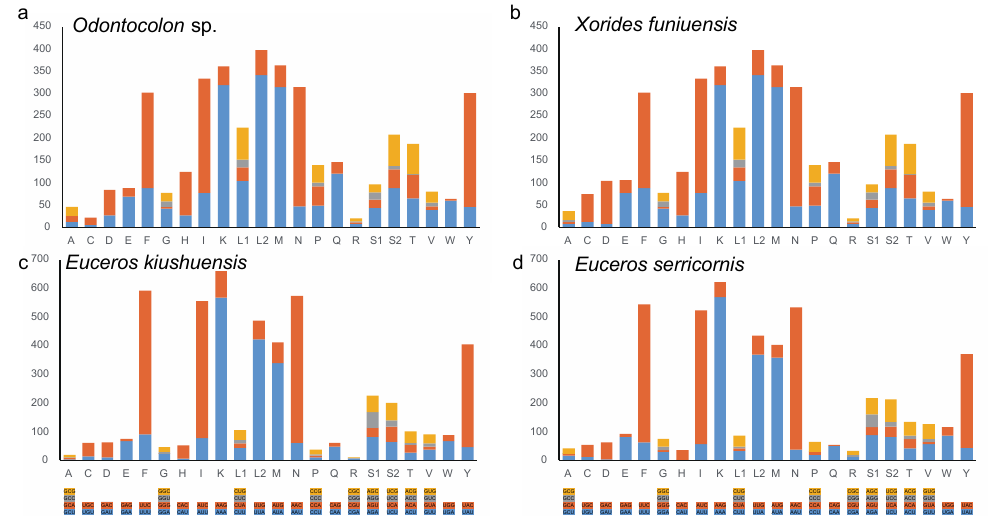
Figure 1. Relative synonymous codon usage (RSCU) in the mitochondrial protein-coding genes (PCGs) that four mitogenomes of Ichneumonidae sequenced in this study. The y-axis represents the counts for condon and animo acid usage. The terminal codon is not given. ( a ) The RSCU counts of Odontocolon sp.; ( b ) The RSCU counts of X. funiuensis ; ( c ) The RSCU counts of E. kiushuensis ; ( d ) The RSCU counts of E. serricornis .